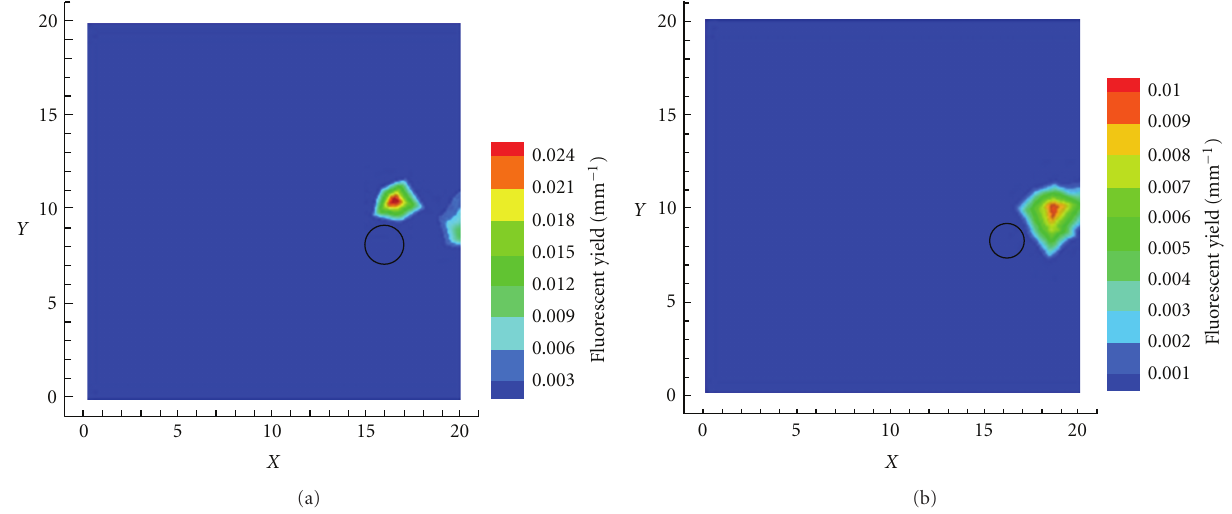
Figure 8: Recovered results by the algebraic reconstruction technique (a) and l 2 -norm regularization method (b). method. It is shown that their fluorescence yields